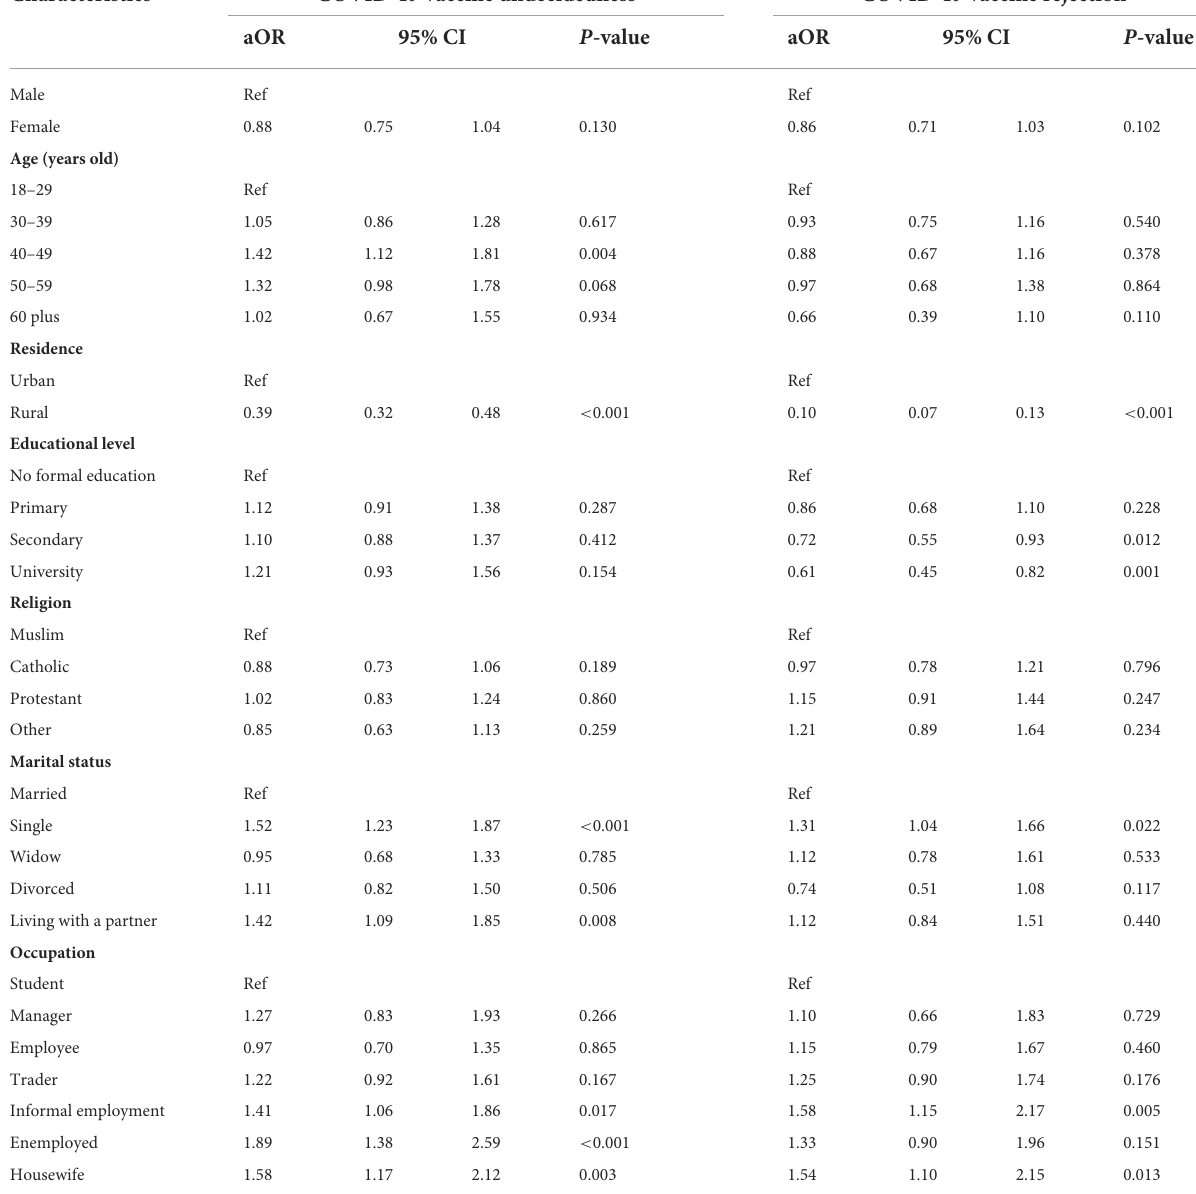
TABLE 4 Socio-demographic predictors of COVID-19 vaccine undecidedness or rejection: multivariate analysis. Characteristics COVID-19 vaccine undecidedness COVID-19 vaccine